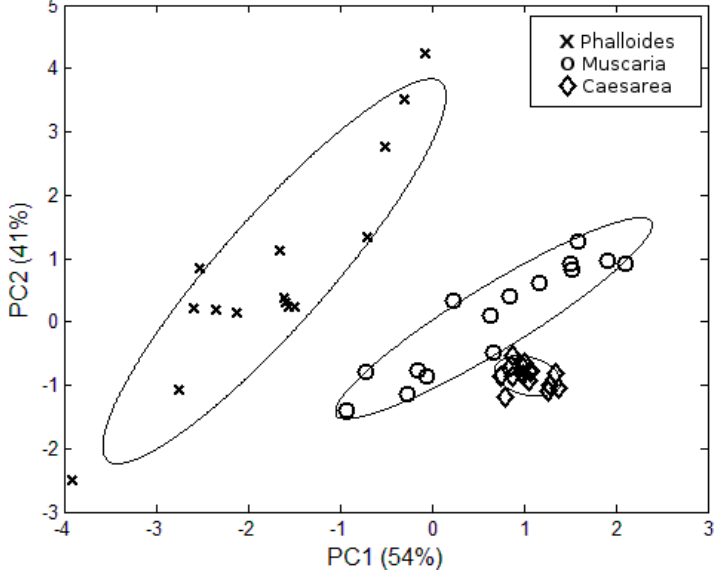
Figure 1. PCA score plot of amanita